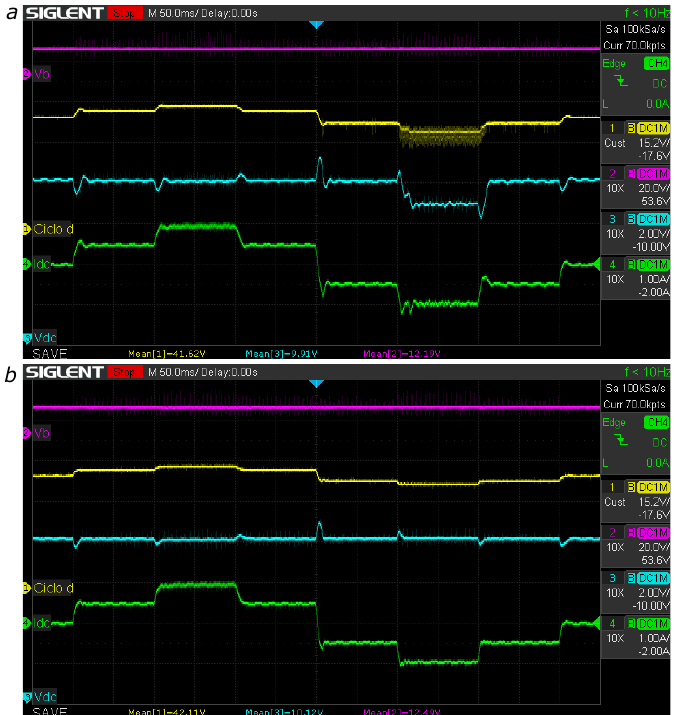
= 10 V (buck mode) using ( a ) PI and ref